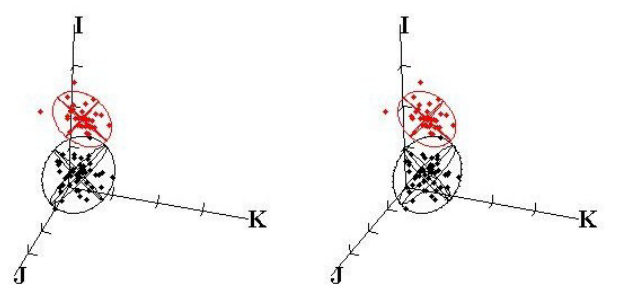
Figure 4. Stereo-pair scatter plot (with included 95% distribution ellipsoids) of C1: 50 auto-keratometric measurements taken before (black data points) and C2: 50 auto-keratometric measurements taken after (red data points) three hours of no contact lens wear. The origin of the scatter plot is 45.65 I D. Table 1 . Statistics (means, variance-covariance matrices and ellipsoid volumes) for the first subject from the PMMA group, RGP group and control